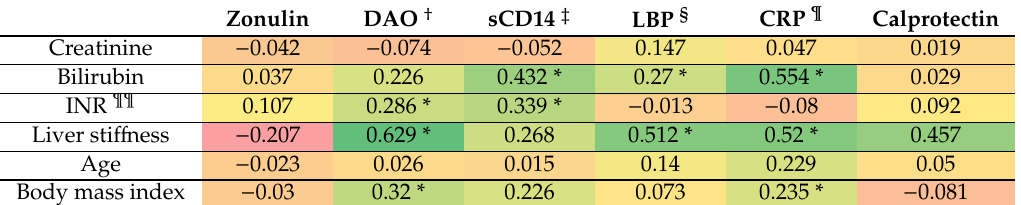
Table 11. Heatmap showing correlations between markers of gut permeability, bacterial translocation, intestinal and systemic inflammation and markers for liver function, kidney function, age and BMI. Spearman’s correlation coe ffi cient is shown. Significant results ( p < 0.05) are indicated by *. The